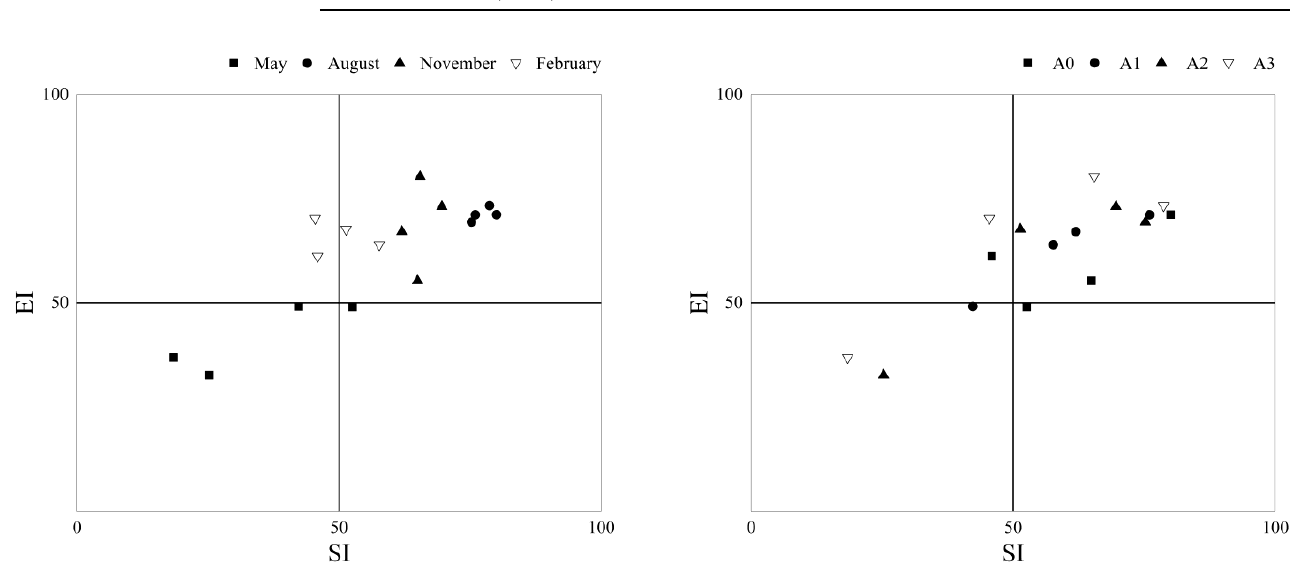
Figure 3. Flora analysis of nematode worms. EI, enrichment index; SI, structure index.